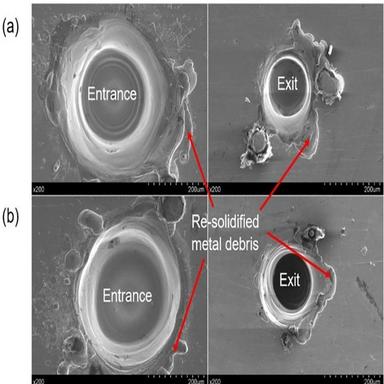
Unground through-hole entrances and exits drilled using five laser pulses (a) without and (b) with water-based ultrasonic assistance.